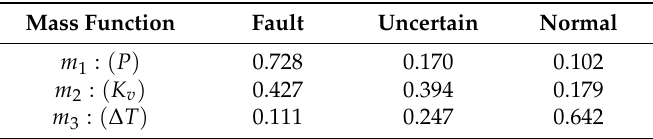
Table 11. The mass functions.